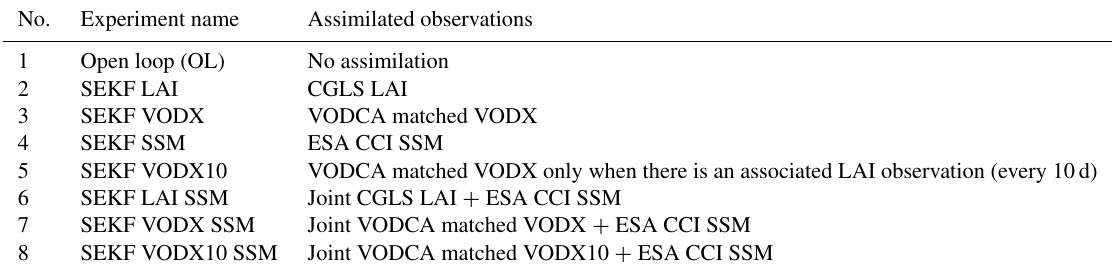
Table 2. List of experiment names and their assimilated observations analyzed.